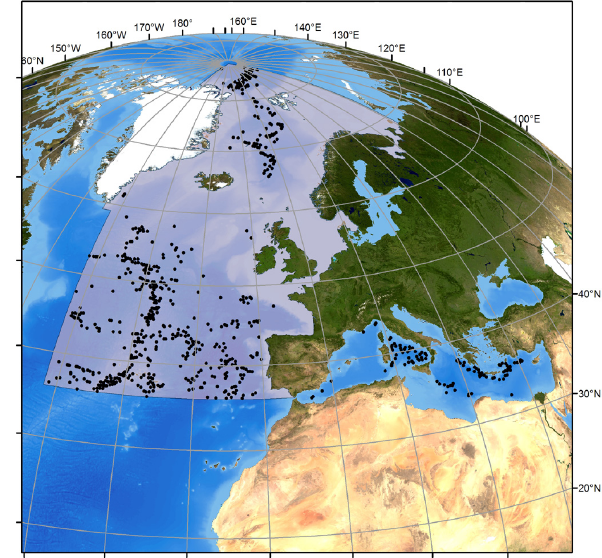
Fig. 1. Outlines of the bathymetry layers used to detect seamounts in the OSPAR area (north-east Atlantic) and the Mediterranean Sea. (1) is the Arctic grid; (2) is the north-east Atlantic grid; (3) is the Ireland grid; (4) is the south-west Iberian margin grid; (5) is the Azores grid; (6) is the Mid-Atlantic Ridge grid; (7) is the Mediter- ranean 250 grid; (8) is the Mediterranean 800 grid; and (9) is the GEBCO global grid (see Table 1 for details).